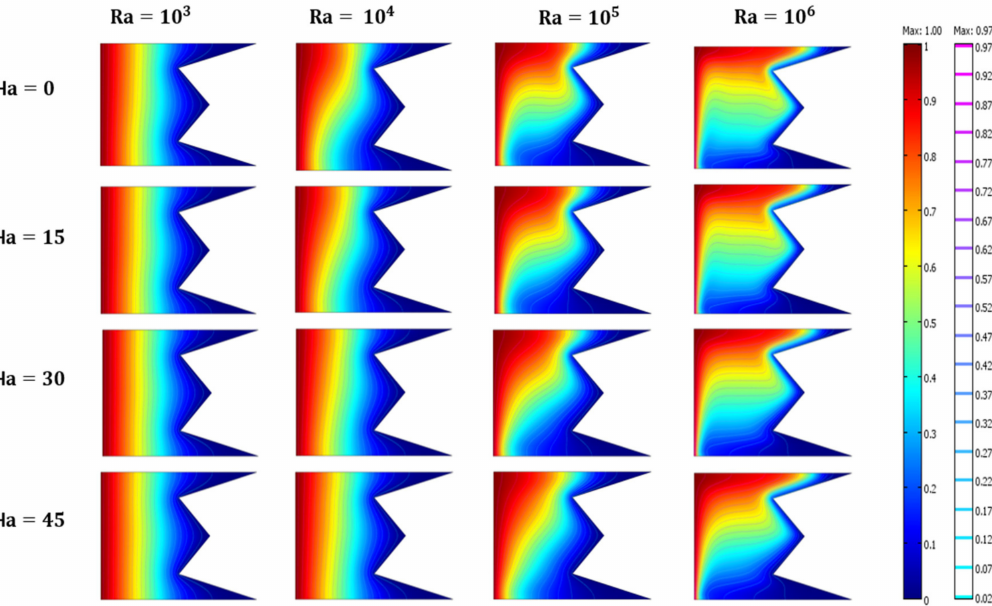
Figure 5. Isotherms for di ff erent values of Rayleigh numbers (Ra = 10 3 , 10 4 , 10 5 and 10 6 ) and Hartmann numbers (Ha = 0, 15, 30 and 45), Da = 10 − 2 , aspect ratio (AR) = 0.3, ω = 0, ϕ = 0.04, Fr = 0.75 and q ∗ = 1.